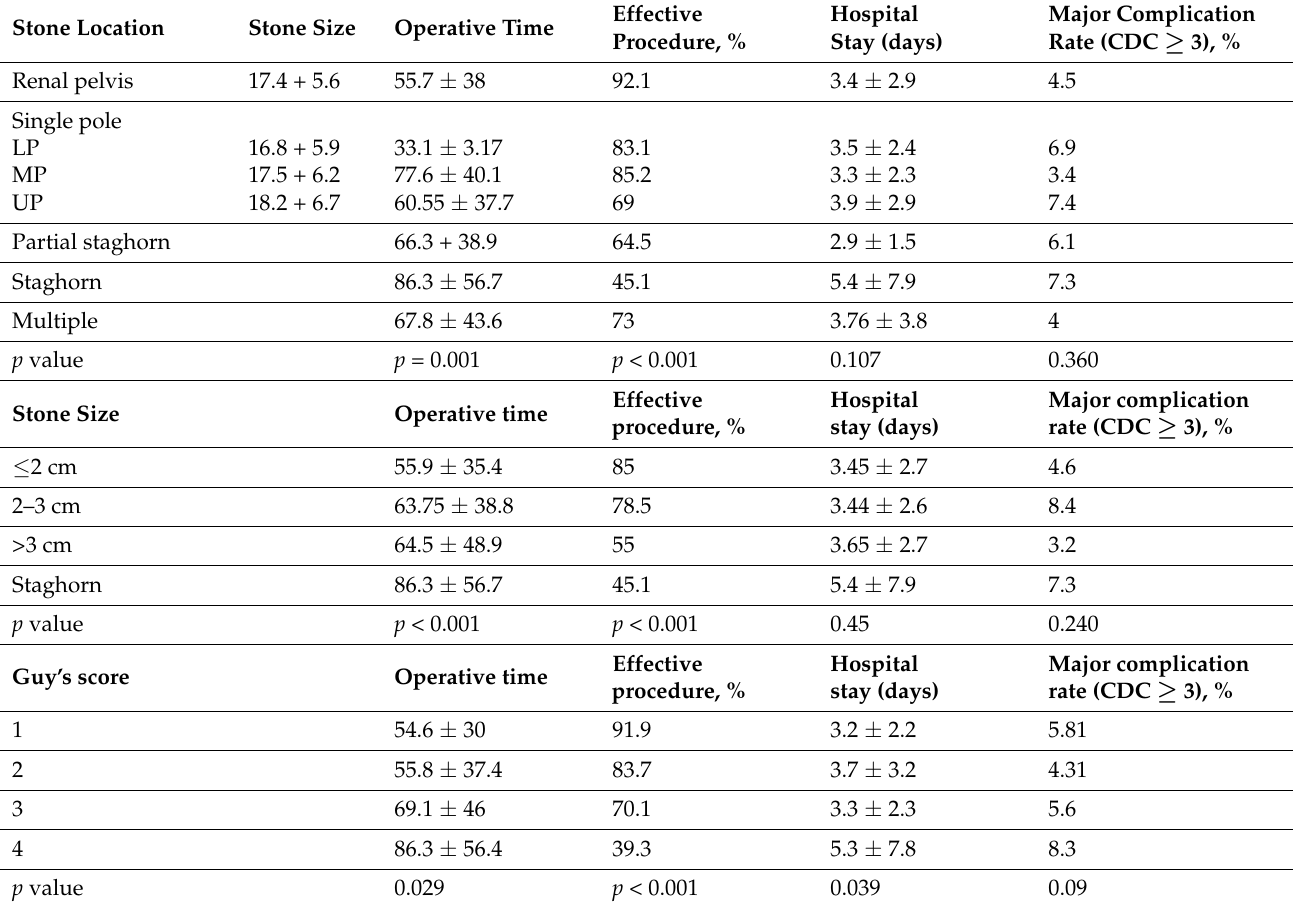
Table 5. Effectiveness of supine PCNL, stratified by stone position, size and Guy’s